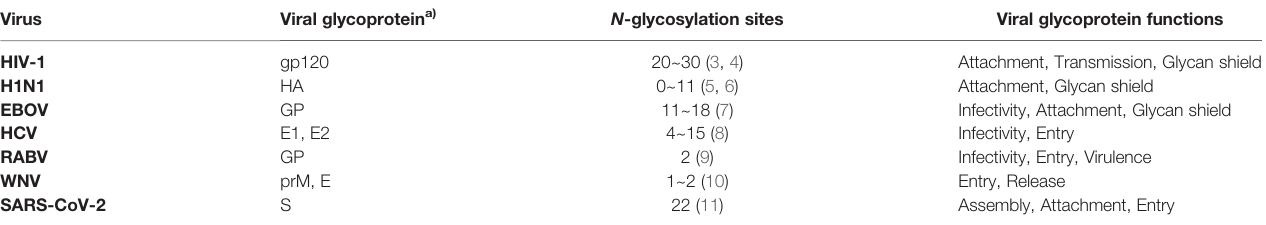
TABLE 1 | Glycosylation of viral envelope proteins and its functions.